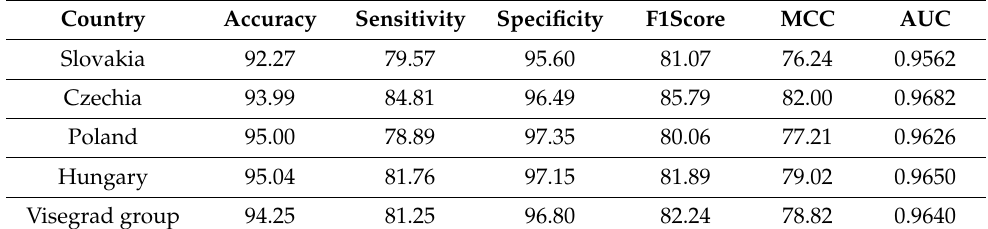
Table 11. The performance metrics of models for each Visegrad member country.